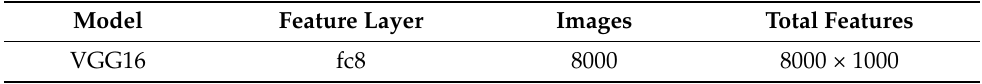
Table 1. Overview of extracted